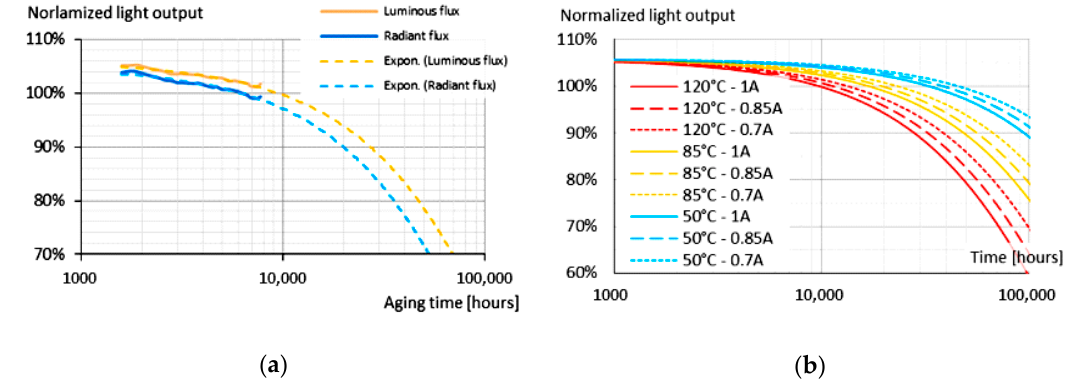
I F = 850 mA and 700 mA.